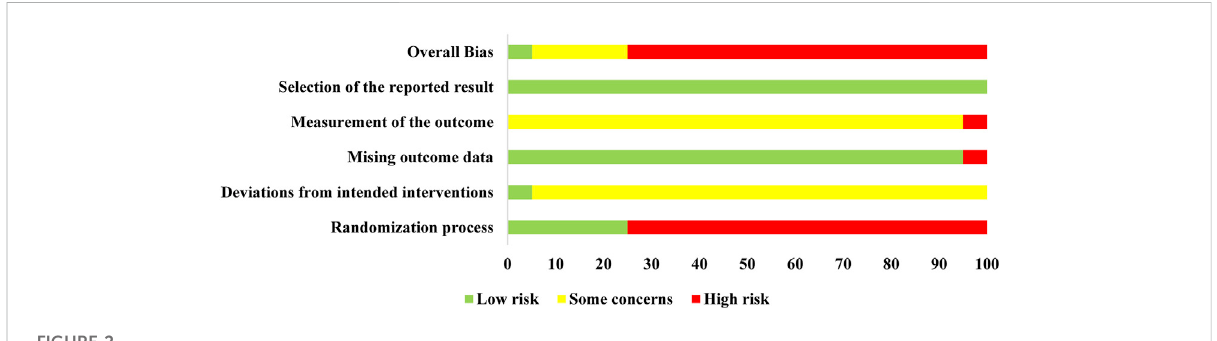
FIGURE 2 Risk of bias assessment in studies.